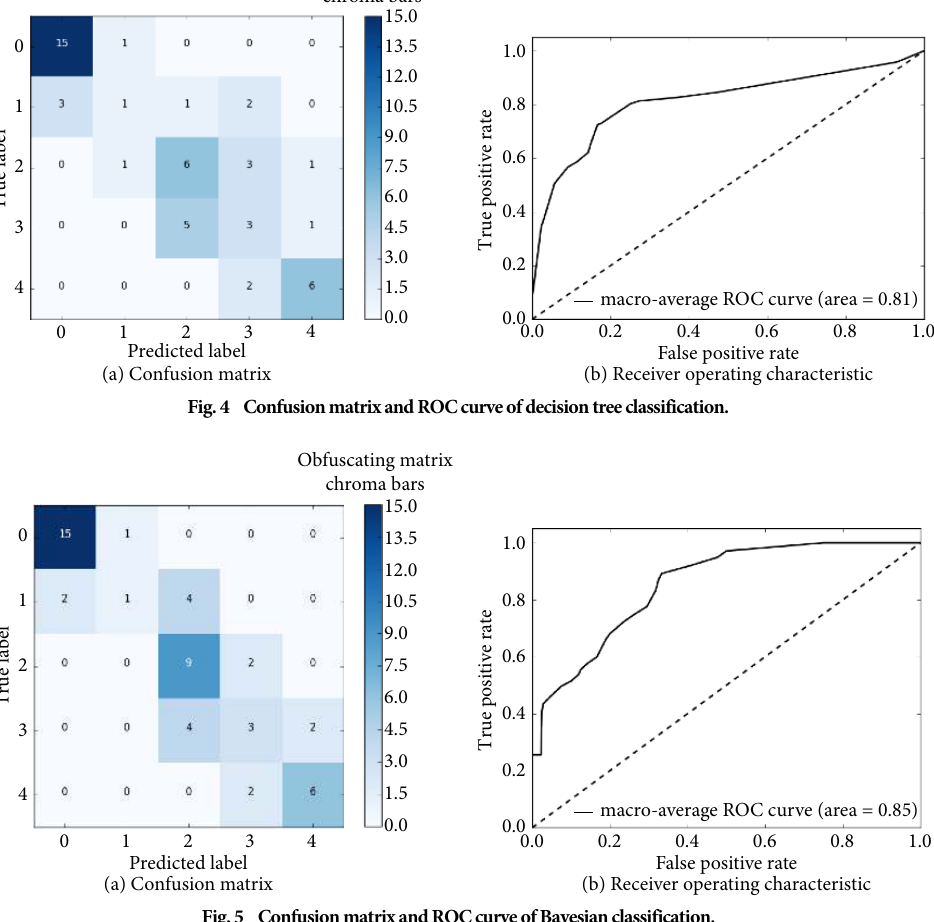
Fig. 5 Confusion matrix and ROC curve of Bayesian classification.